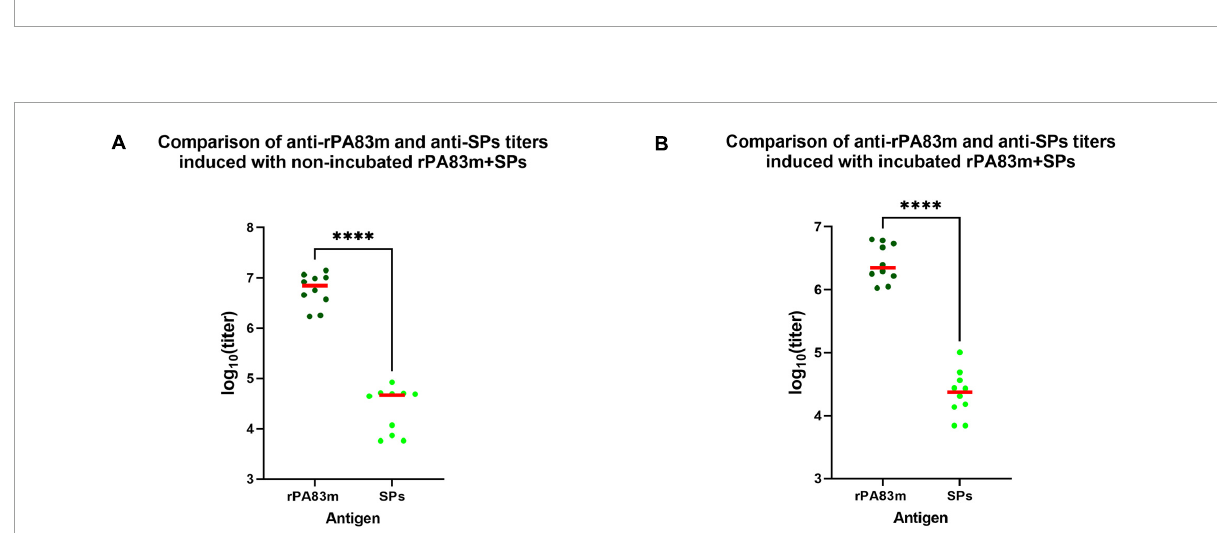
FIGURE5 Immunogenicity of rPA83m as a part of various formulations in guinea pigs. (A) Comparison of immunogenicity of non-incubated rPA83m formulations. (B) Comparison of immunogenicity of incubated rPA83m formulations. (C) Comparison of immunogenicity of non-incubated and incubated rPA83m + Al(OH) 3 . Incubated formulations marked with “inc.” were incubated at +37 ◦ C for 27 days. Groups of guinea pigs were immunised subcutaneously twice at 28-day intervals. The scheme of the study is presented in Figure 4 . Blood was collected from the marginal ear vein 20 days after the second immunisation. Sera titres were evaluated using indirect ELISA (antigen concentration on microplate—10 µ g/ml). P -values were calculated using the Kruskal-Wallis test with a post hoc Dunn’s test for multiple comparisons (A,B) or the Wilcoxon-Mann-Whitney Test for two groups comparison (C) . ∗ P < 0.05, ∗∗ P < 0.01, ∗∗∗ P < 0.001. The complete data on anti-rPA83m sera titres for each guinea pigs immunisation group are presented in Supplementary Table 1 .